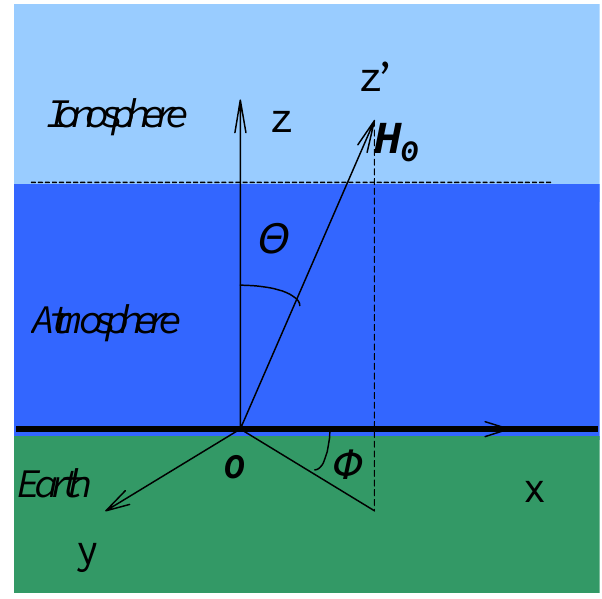
Fig. 1. Geometry of the problem. (XYZ) are local Fig.1. Geometry of the problem. (XYZ) are local coordinates.